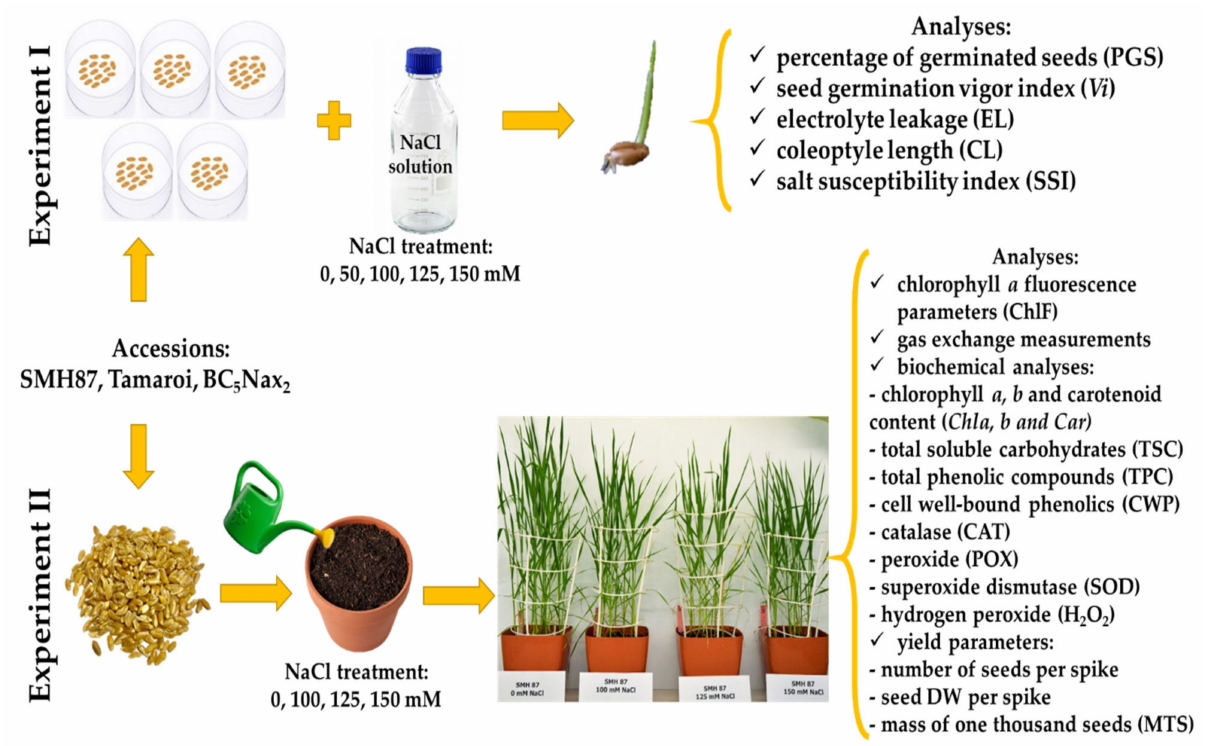
Figure 8. Design of the